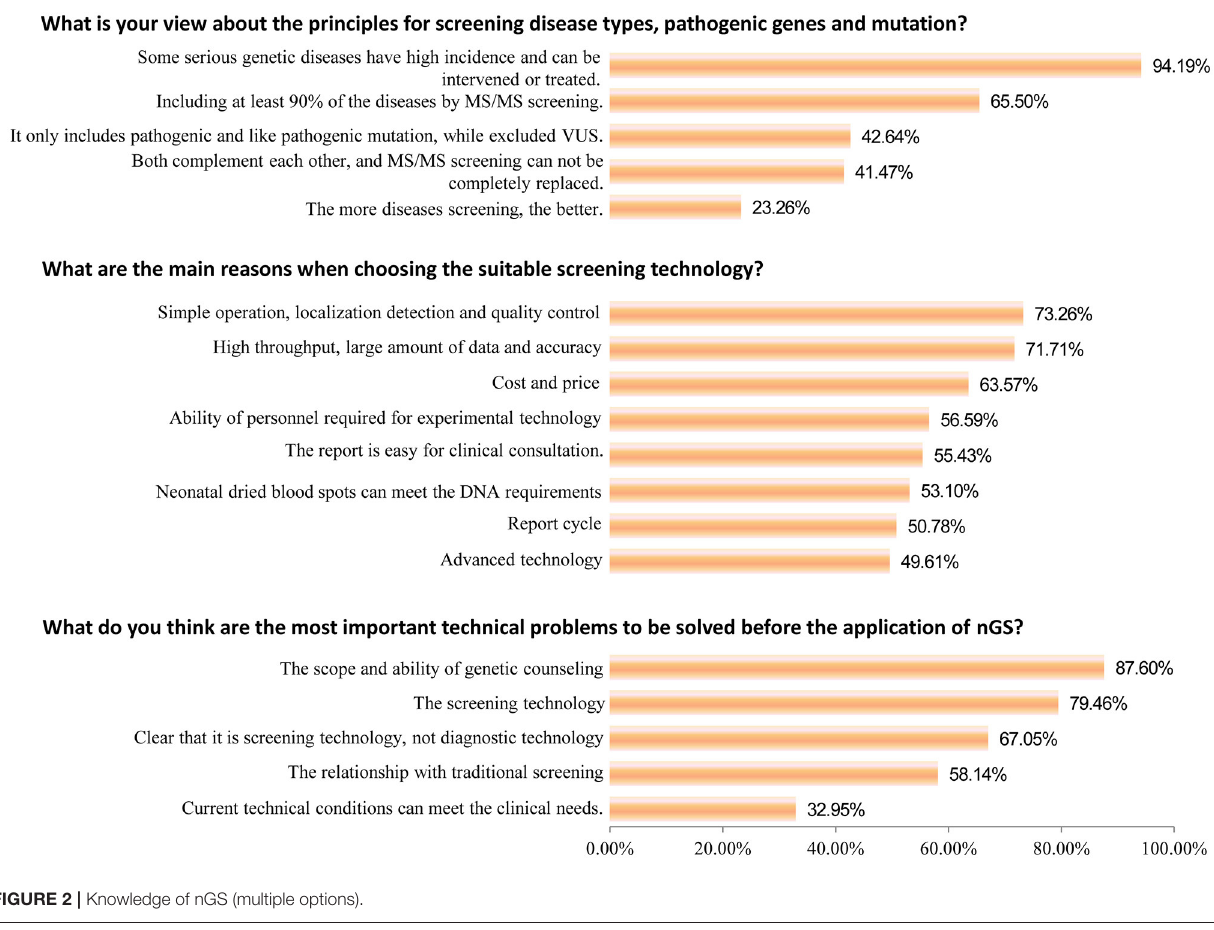
FIGURE 2 | Knowledge of nGS (multiple options).